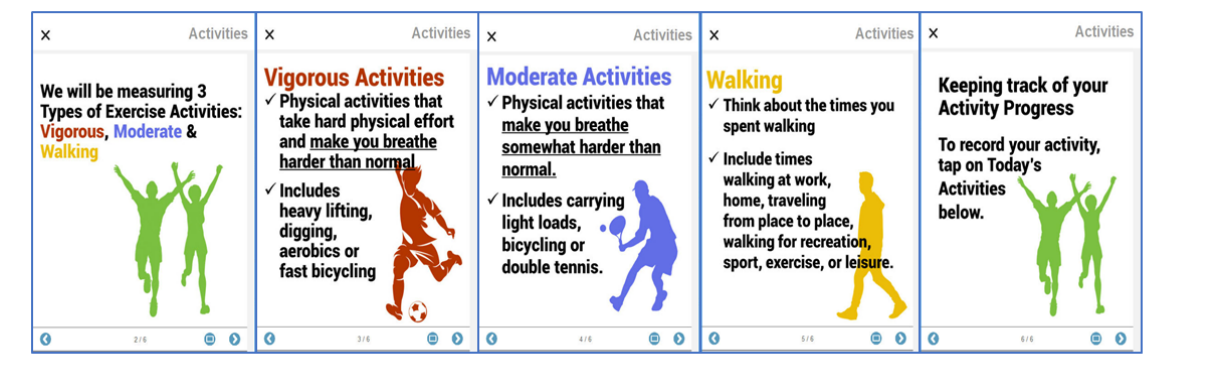
Figure 5. Explanation of levels of activity effort to support quality diary entries.